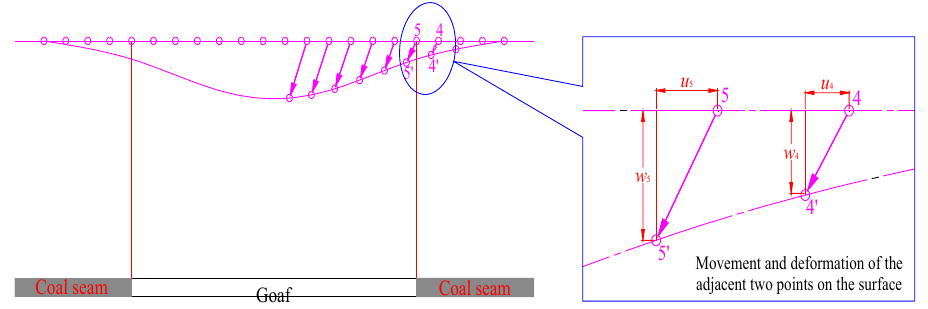
Figure 7. Movement of each point in the overburden rock after shallow coal seam